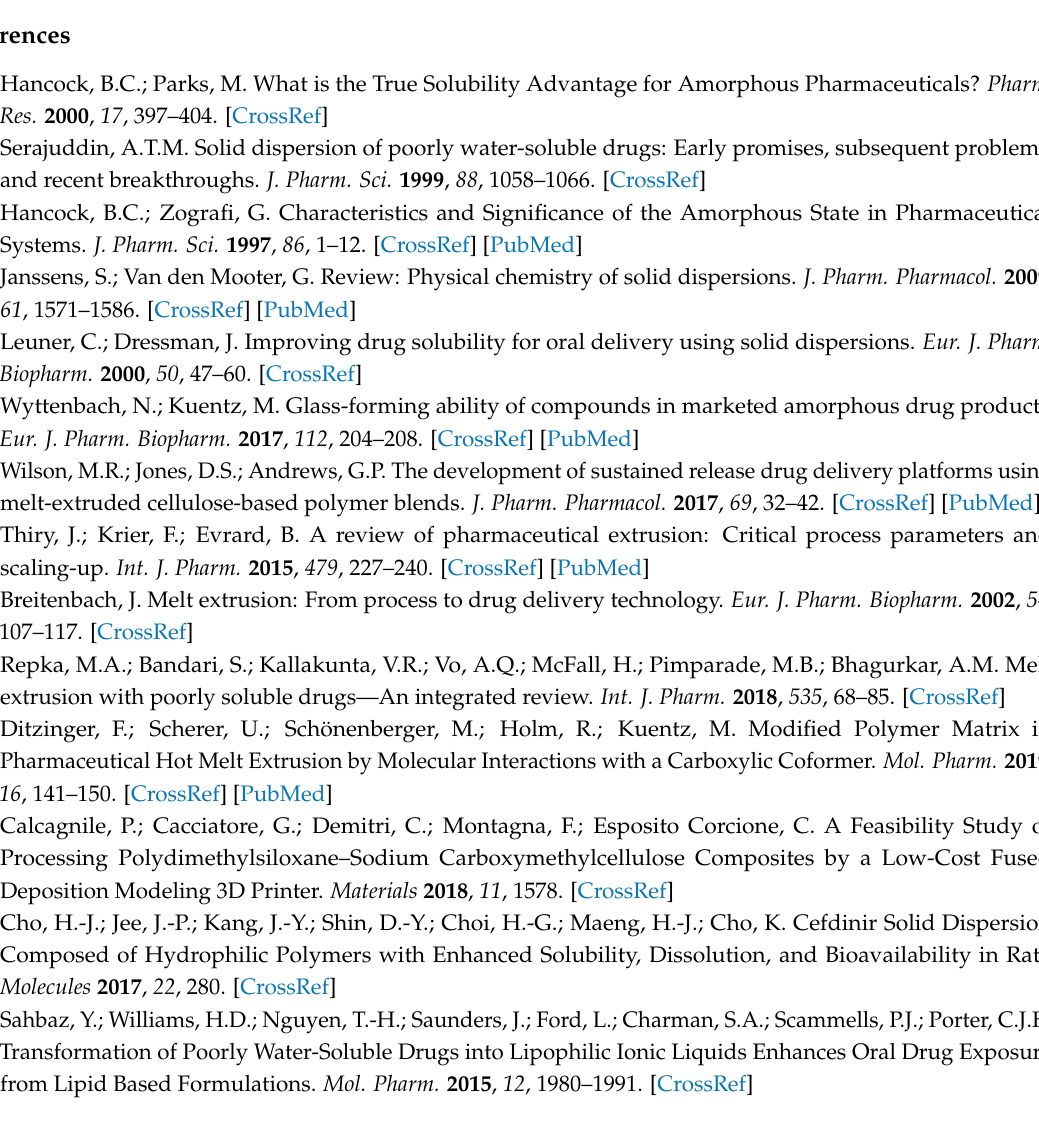
Figure S1: X-ray diffraction pattern of physical mixtures, Figure S2: X-ray diffraction pattern of the solvent evaporates, Figure S3: X-ray diffraction pattern of the extrudates, Figure S4: Heat-resolved FTIR and HSM images of lysine/NaCMC, Figure S5: Heat-resolved FTIR and HSM images of